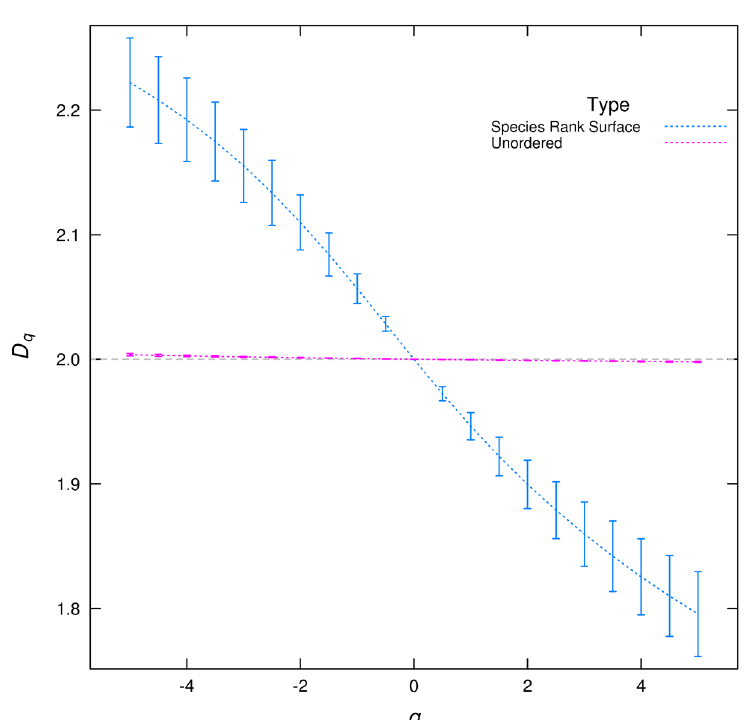
multifractal spectrum. q